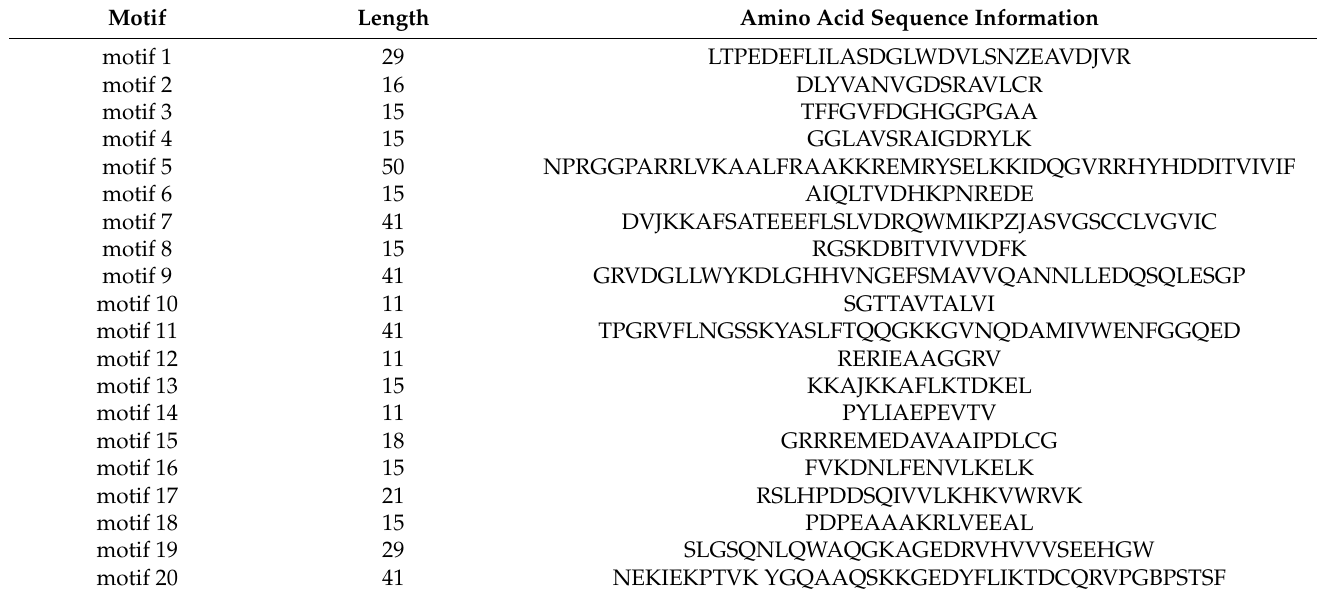
Table 2. Conserved motif information of the PP2C gene family in P. fortunei